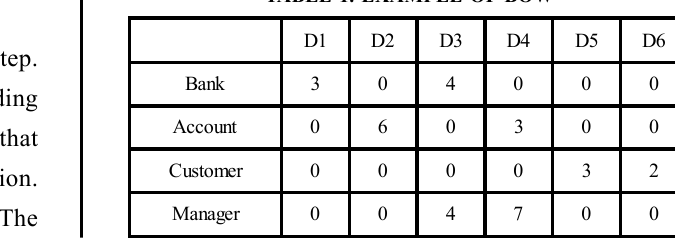
FIG. 2. PREPROCESSING STEPS FOR TEXT DOCUMENTS COLLECTION TABLE 1. EXAMPLE OF